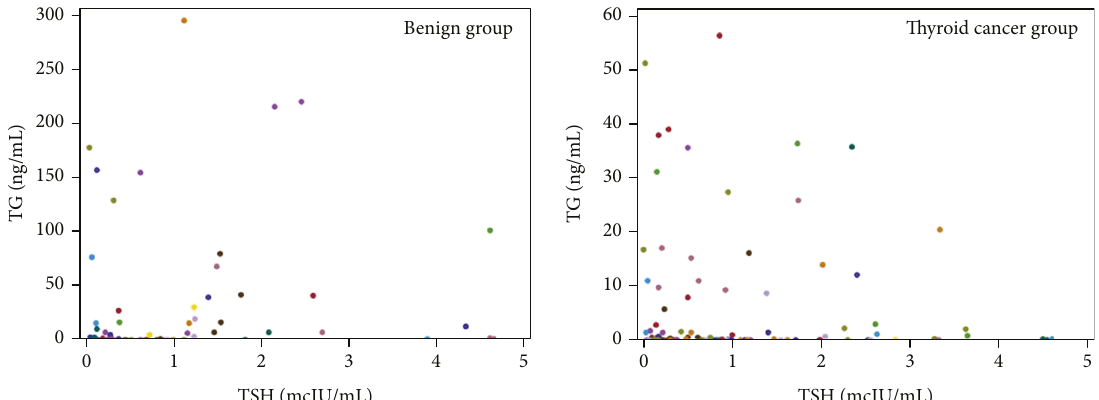
Figure 2: Relation of TSH and TG levels in both groups.